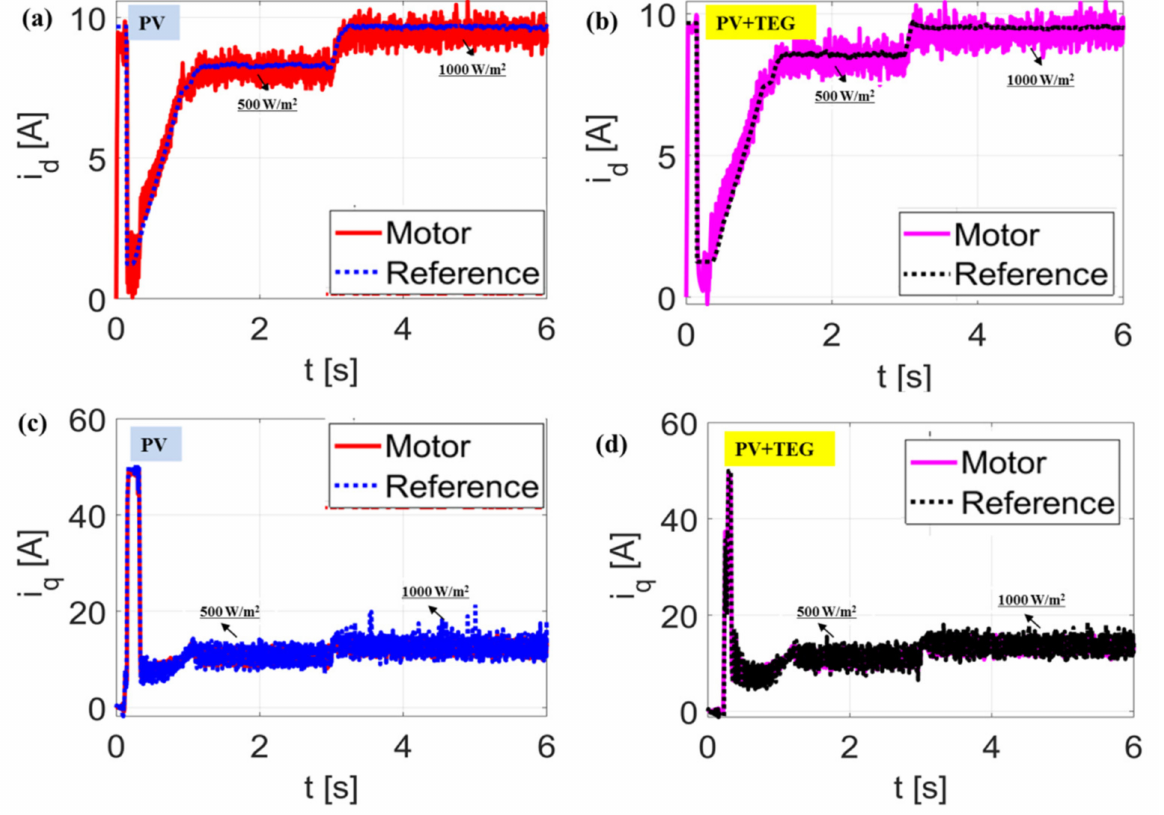
Figure 11. The SynRM current components with time where ( a , b ) are the direct axes currents and ( c , d ) are the quadrature axes